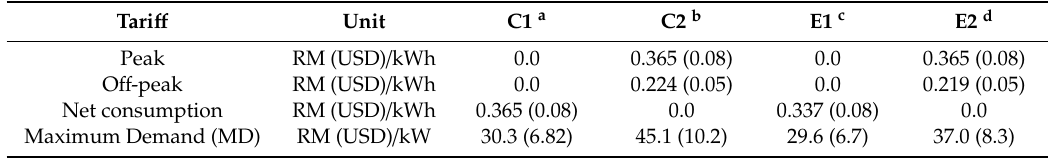
Table 1. Malaysia electricity tari ff categories (Medium Voltage